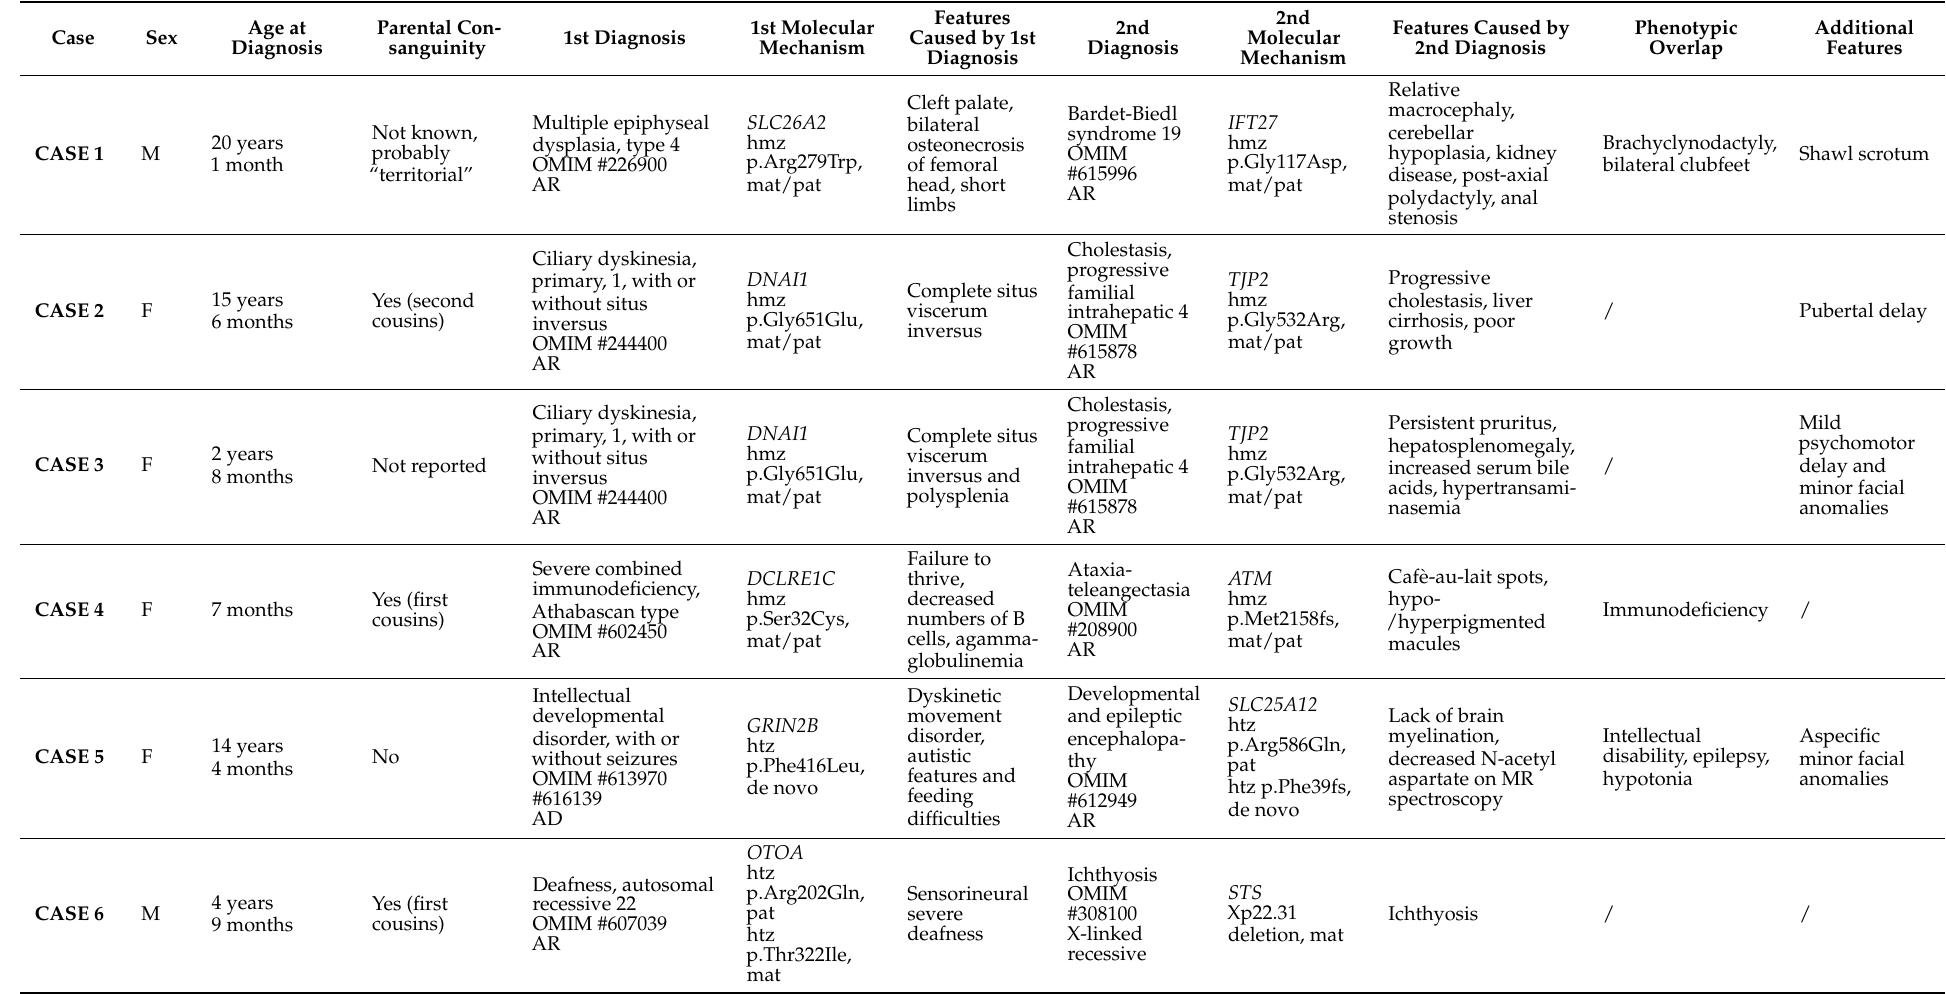
Table 1. Overview of the patients’ genetic diagnosis and their respective contributions to the